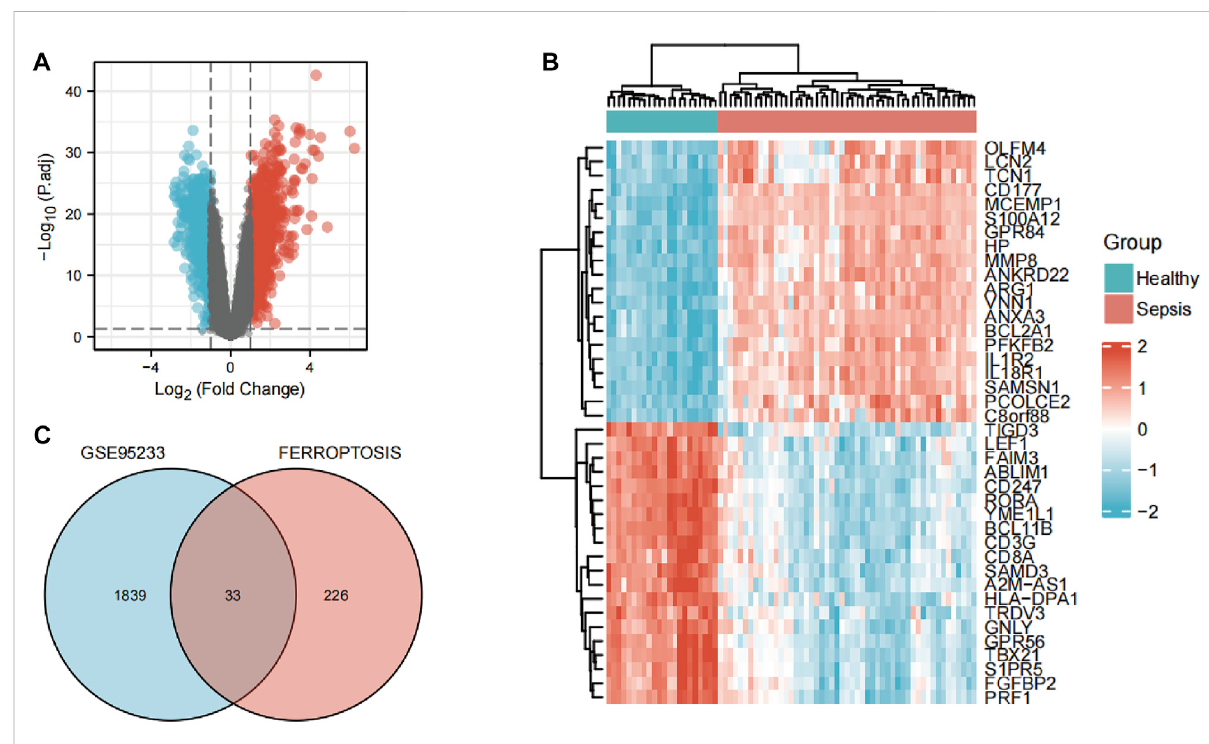
FIGURE 2 Identi fi cation of ferroptosis-related differentially expressed genes (DEGs). (A) Volcano plots of DEGs. (B) Heatmap of DEGs identi fi ed in GSE95233. (C) Venn diagram of ferroptosis-related